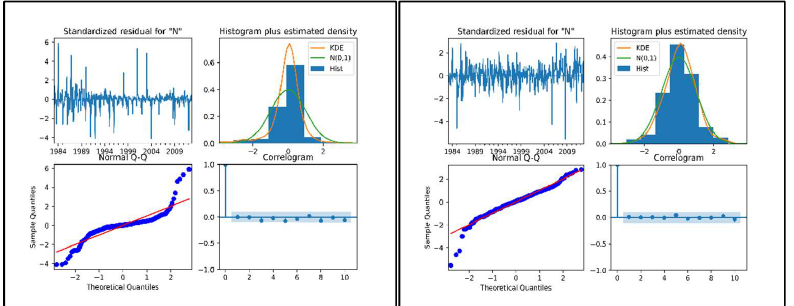
Figure 5. Diagnostic checking of the standardized residuals, histogram, normal Q-Q, and correlogram plots of the SARIMAX (right side) and SARIMA (left side) model for natural gas production.